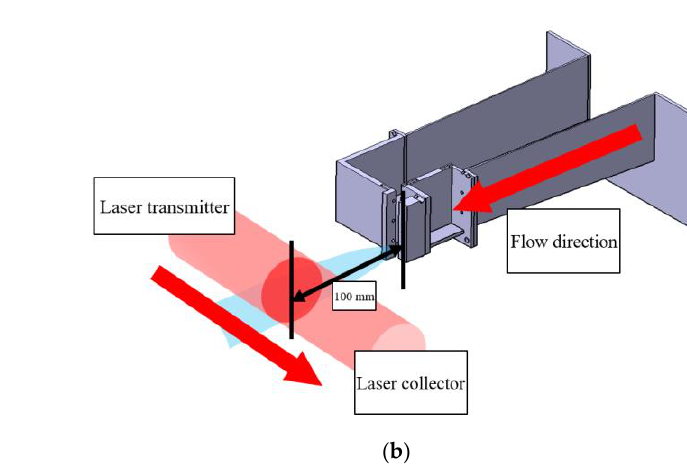
Figure 5. Schematic diagram of the experimental setup.